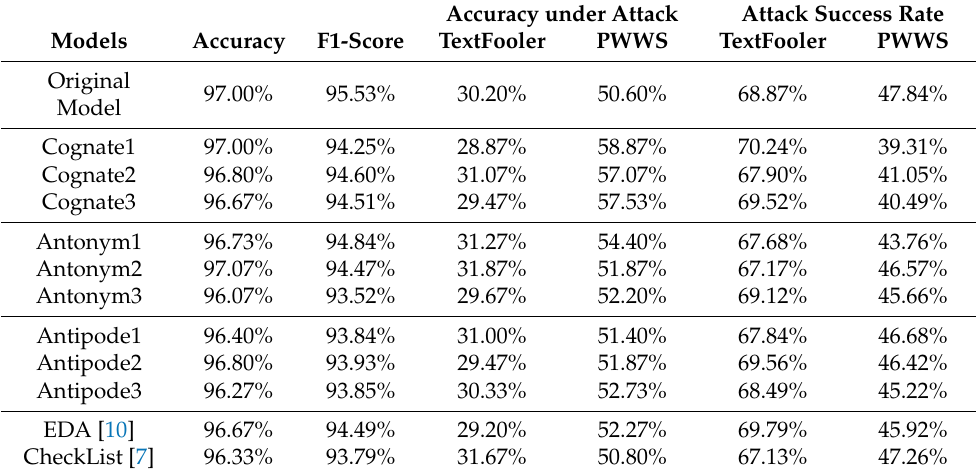
Table A2. TREC Performance and Robustness Results.